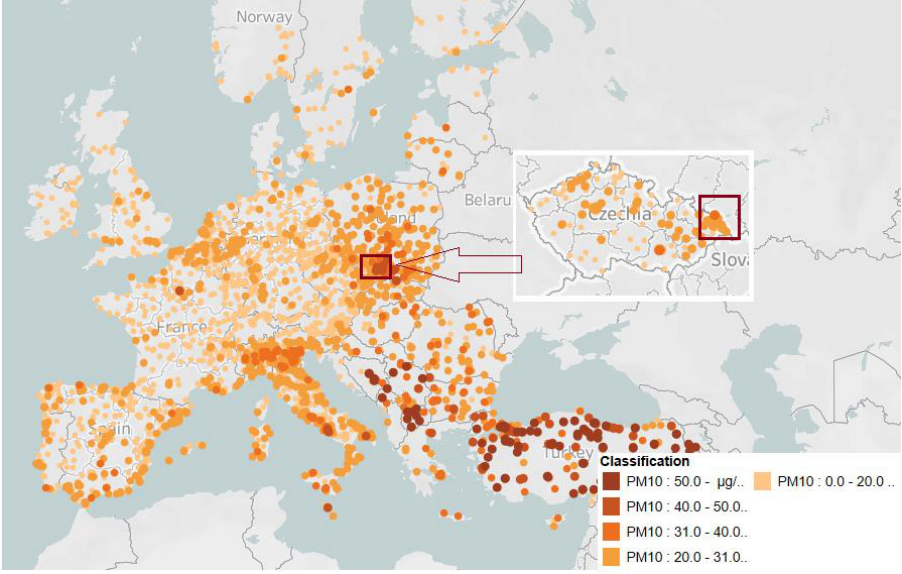
Figure 1. The annual mean of particulate matter PM 10 in 2019 in the area of interest (Northeast Czech Republic) [5].